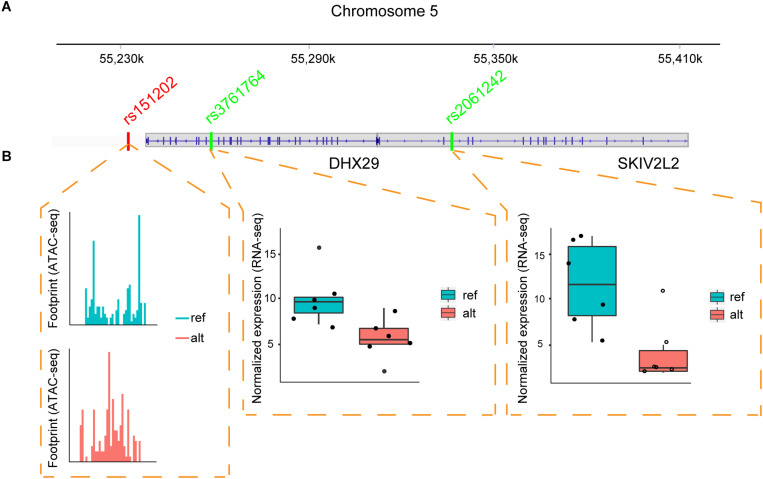
Regulatory SNP affects the expression of two target genes. (A) Illustration of the relative positions of the candidate regulatory SNP (red) and coding-region SNPs (green) located within two target genes (DHX29, SKIV2L2) in MCF-7 cells. Vertical blue lines indicate exons. (B) ATAC-seq and RNA-seq data suggest the regulatory SNP can drive an ASB event. The ATAC-seq footprint shows preferential TF binding on the reference allele at the regulatory SNP. Boxplots from RNA-seq data across six samples show the gene expression values of the two target genes is increased in the alternative allele.